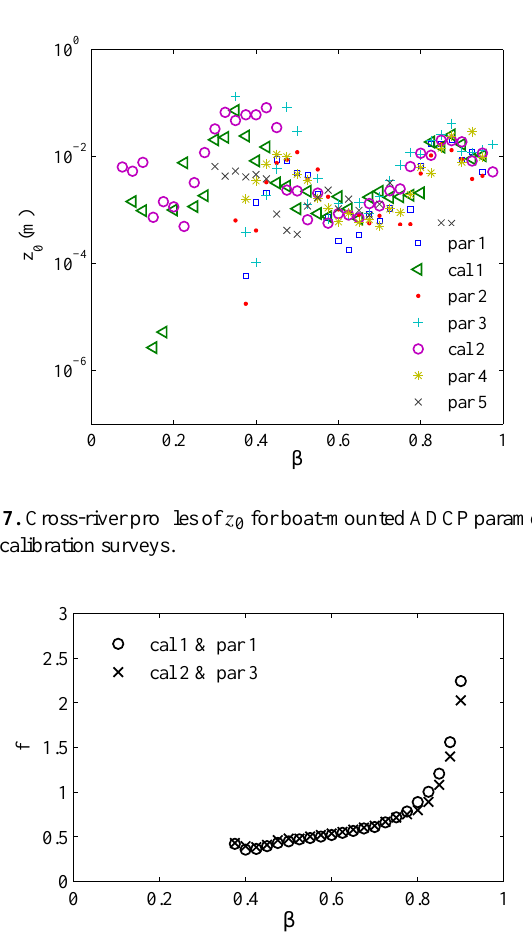
Fig. 8. Amplification factor f obtained for quasi-simultaneous boat-mounted ADCP parameter and calibration surveys.